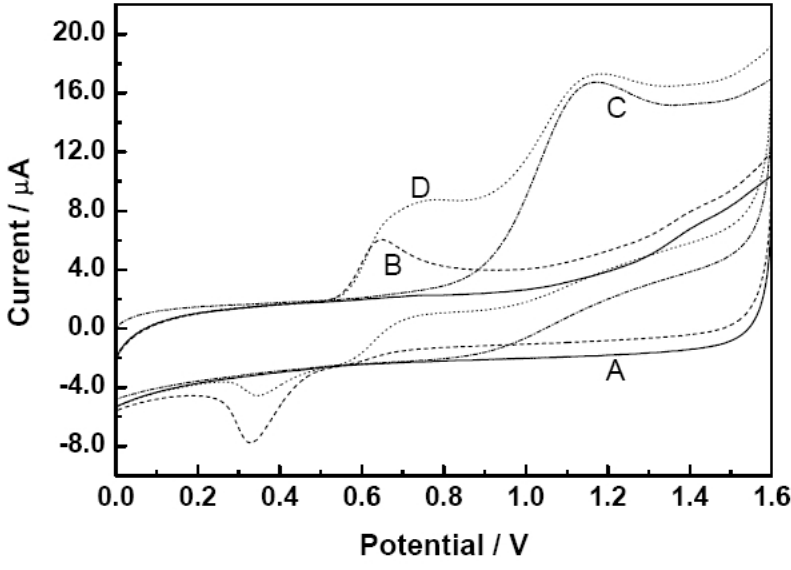
Fig. 2 CVs obtained on BDD electrode in 0.1 M HClO 4 solution(A), A+ 1 × 10 − 4 M DA (B), A+1 . 0 × 10 − 3 M AA (C), and A+ 1 × 10 − 4 M DA +1 . 0 × 10 − 3 M AA (D) ; (Sweep rates 0.1 V s − 1